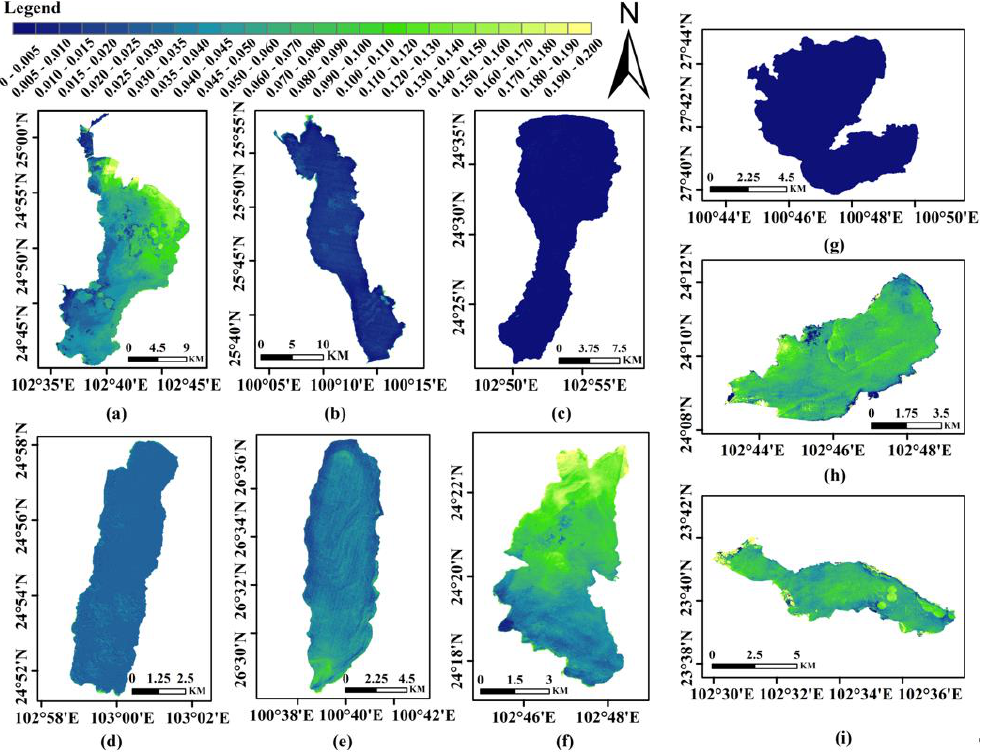
Figure 4. Retrieval of the chlorophyll-a concentrations in nine plateau lakes on June 22 and